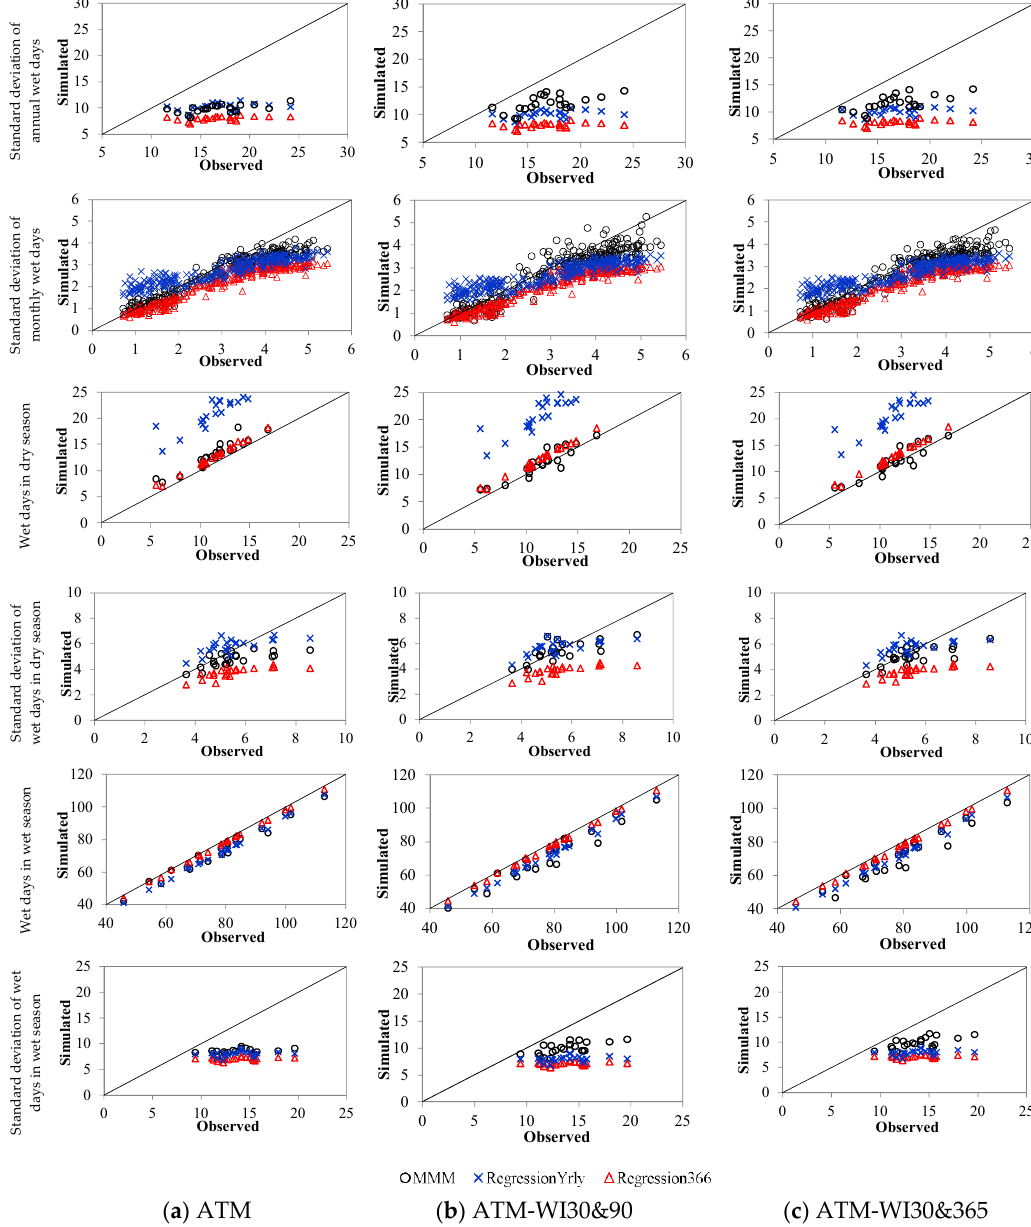
Figure 5. Multisite model results simulated by all downscaling techniques for validation: ( a ) using ATM as predictors; ( b ) using ATM-WI30&90 as predictors; and ( c ) using ATM-WI30&365 as predictors. Each dot on the plot represents a station. Black hollow circles are for MMM, blue crosses are for RegressionYrly and red triangles are for Regression366 models. Table 3. Statistics of monthly, seasonal and annual wet days simulated by 3 multisite downscaling techniques for calibration and validation periods. Rel. RMSE is presented in brackets.